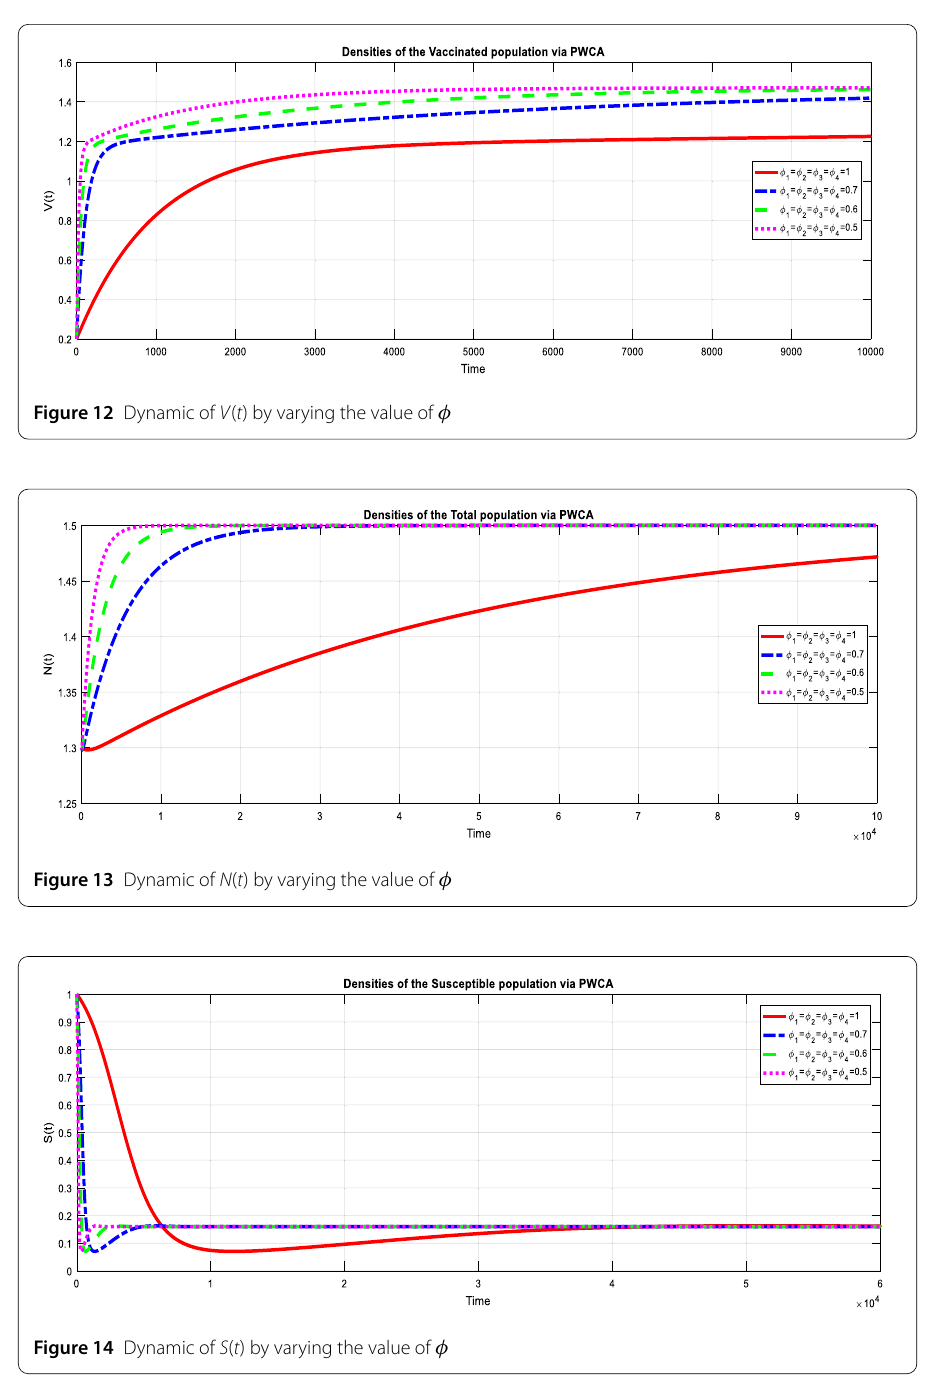
where D α ∗ is the Caputo FD. Let [0, a ] be the interval over which we need to find the result of the problem (23). The interval will be sectioned into ℵ subintervals [ t j , t j +1 ] of identical width h = a by via knots t j = jh , for j = 0,1,2,..., ℵ –1. The common formulation for GEM ℵ when t j +1 = t j + h